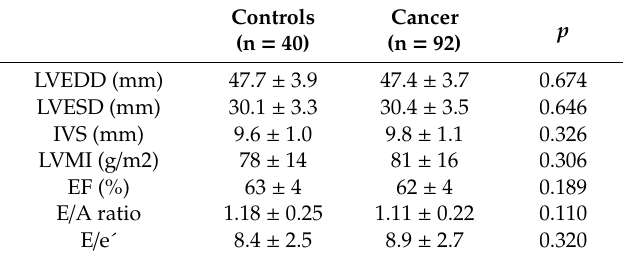
Table 2. Echocardiographic parameters of left ventricular structure and function in the study population